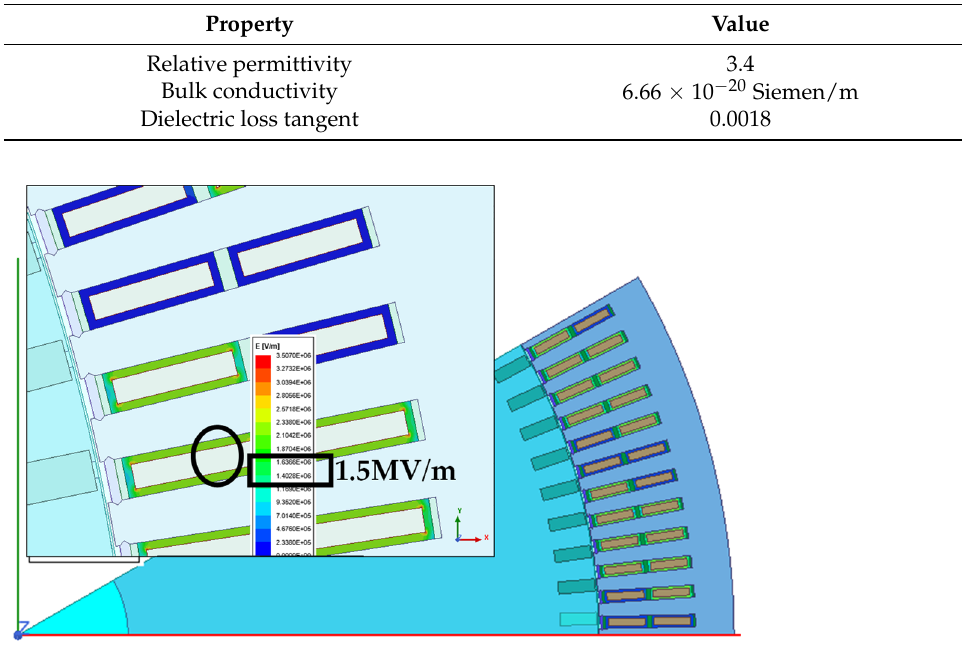
Figure 22. Dielectric stress within the motor stator winding matches the dielectric stress generated by 3 kV peak 2-level waveform using a hardware testbed.